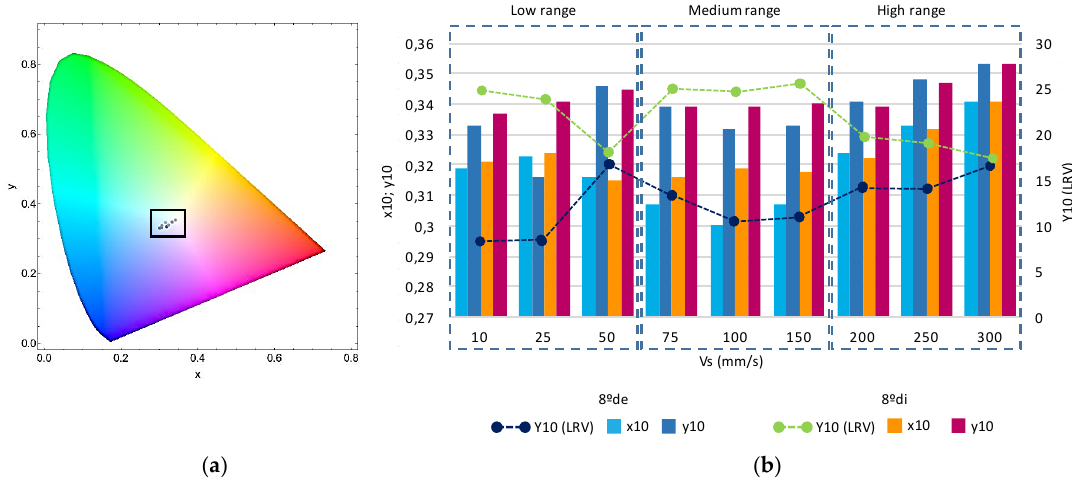
Figure 8. ( a ) Color chromaticity diagram of the textures ( b ) Color coordinate behavior as a function of V s .